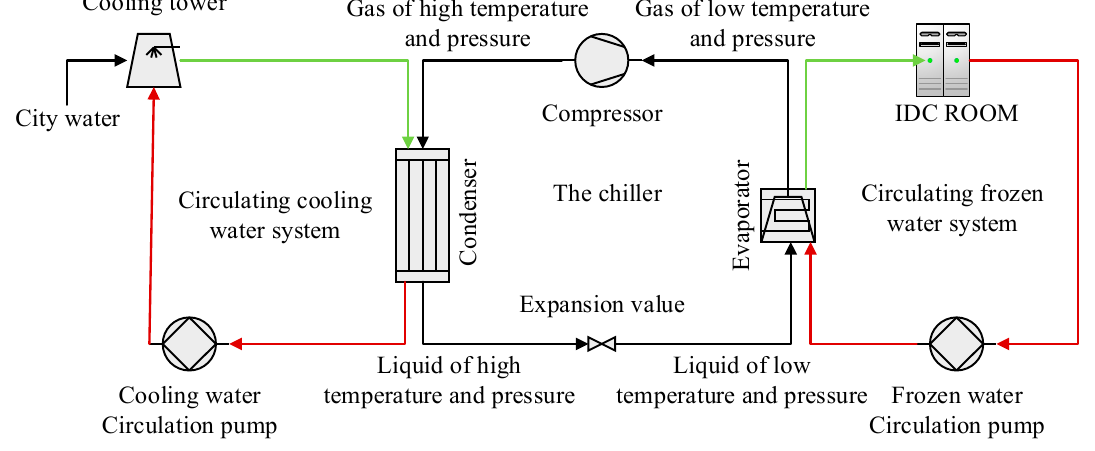
Figure 1. The refrigeration system of IDC.